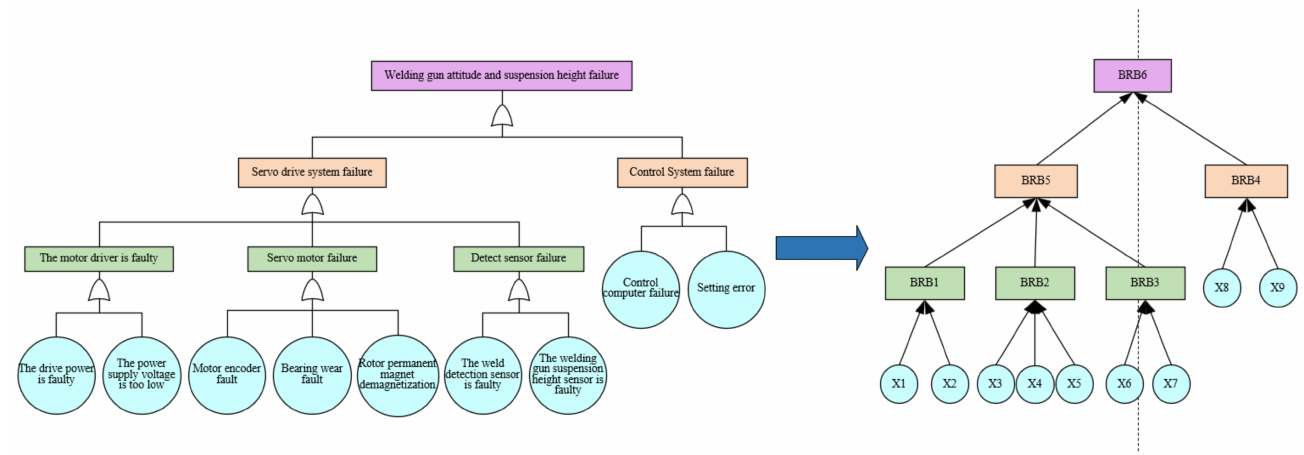
Figure 7. FTA to BRB conversion.